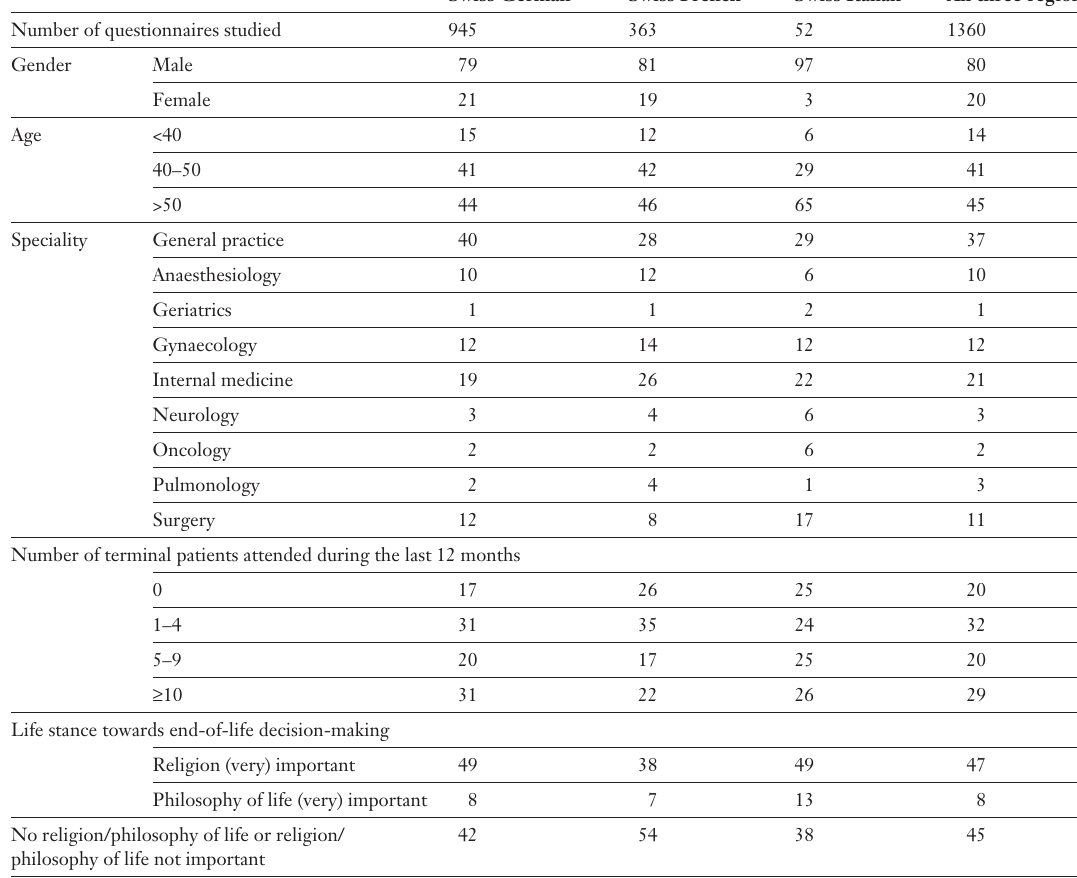
Questionnaires stud- ied (number) and personal characteris- tics of the doctors (weighted percent-